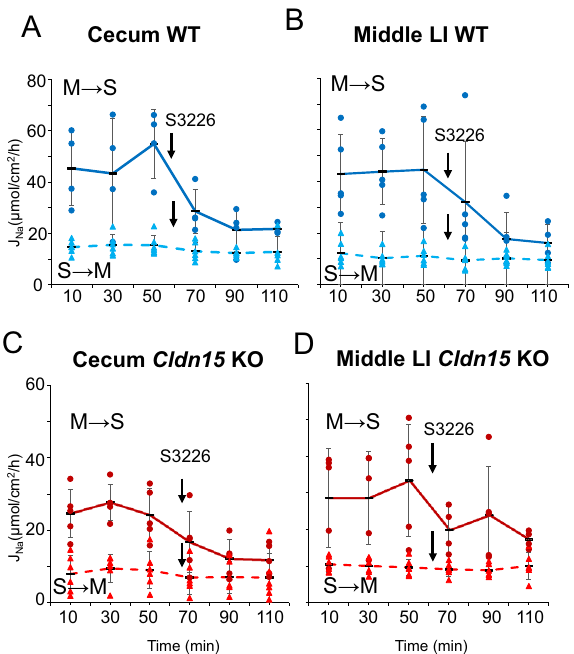
Figure 6. Measurement of unidirectional flux of Na + in the cecum and middle large intestine. Intestinal sheets for the cecum and middle large intestine were prepared by removing the muscle layer and then they were mounted in Ussing chambers. The M → S and S → M unidirectional flux of Na + was measured for each segment. ( A ) Na + flux after each 20-min period in the WT cecum and ( B ) middle large intestine of WT mice. ( C ) Cecum of Cldn15 KO mice. ( D ) middle large intestine of Cldn15 KO mice. The dots represent the individual points and the black bars represent the mean, n = 3–6 (KO: including 1 female). Error bars represent the SD. Please see supplementary table 3 for data points.